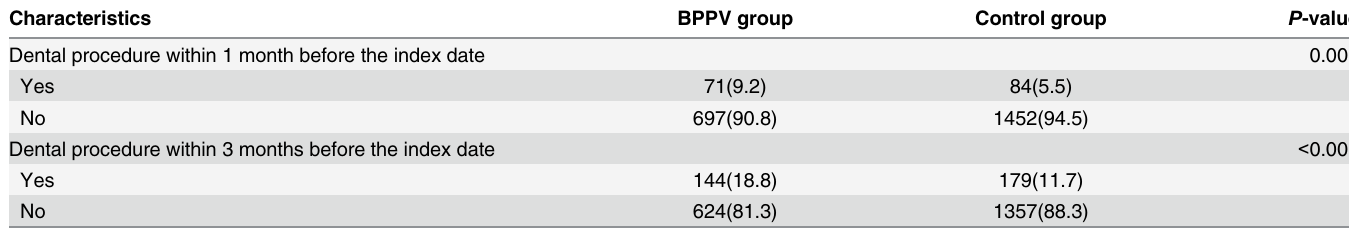
Table 2. Comparison of dental procedures between patients with and without benign paroxysmal positional vertigo.